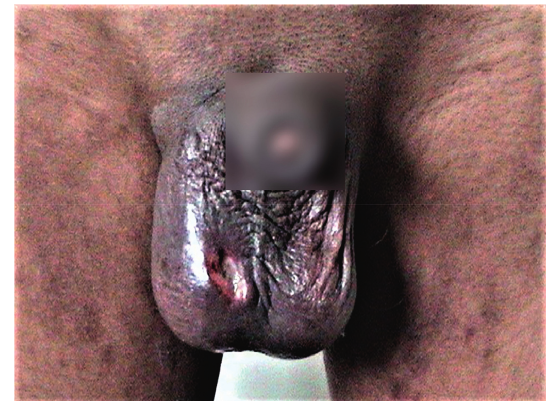
Figure 2: Scrotal wound 5 th day following drainage of fecal